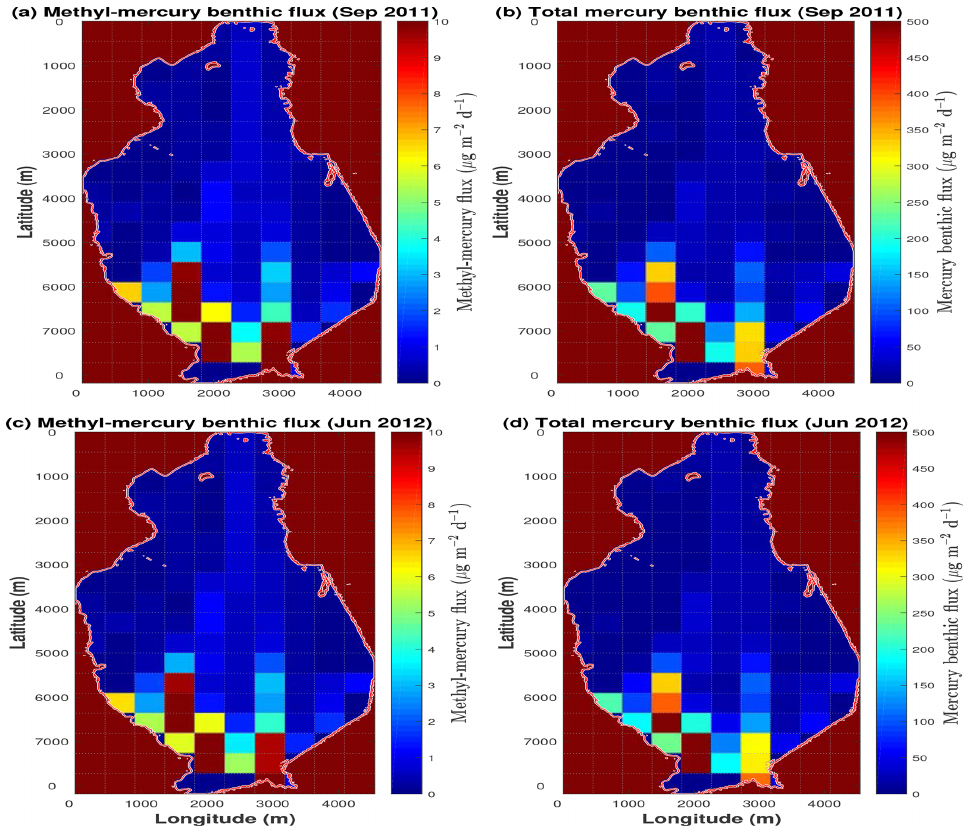
Figure 5. Distribution of MeHg and Hg D fluxes calculated at the seawater–sediment interface. The maps reproduce the spatial distribution of the benthic flux in the Augusta Bay during the two sampling periods, i.e., 19–21 September 2011 (a, b) and 23–26 June 2012 (c, d) .